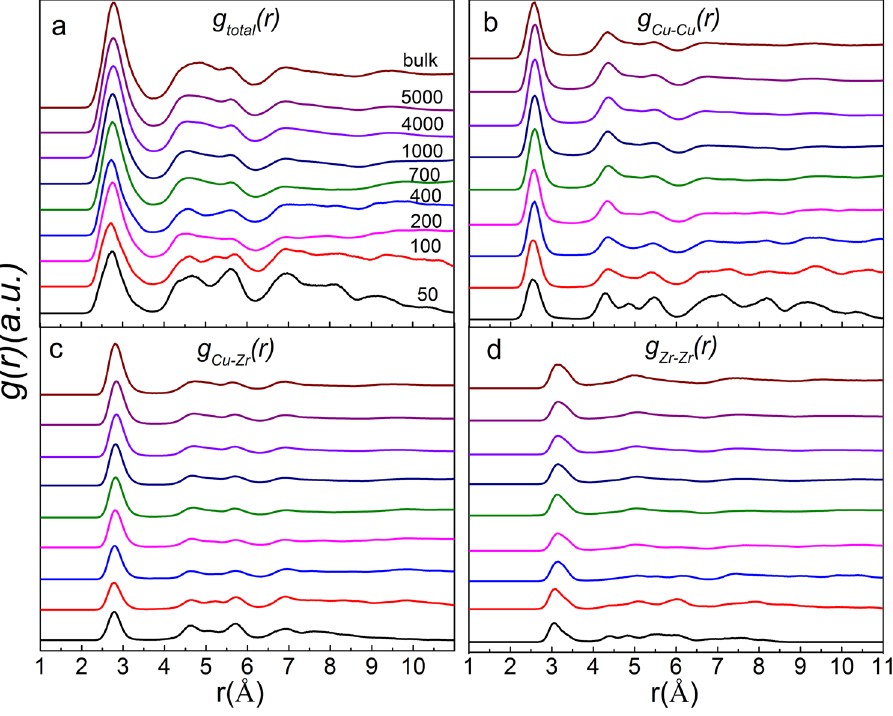
Figure 2. Pair distribution functions g ( r ) for Cu 64 Zr 36 SSAPs with various sizes together with bulk sample for the ( a ) total, ( b ) Cu-Cu partial, ( c ) Cu-Zr partial, ( d ) Zr-Zr partial.